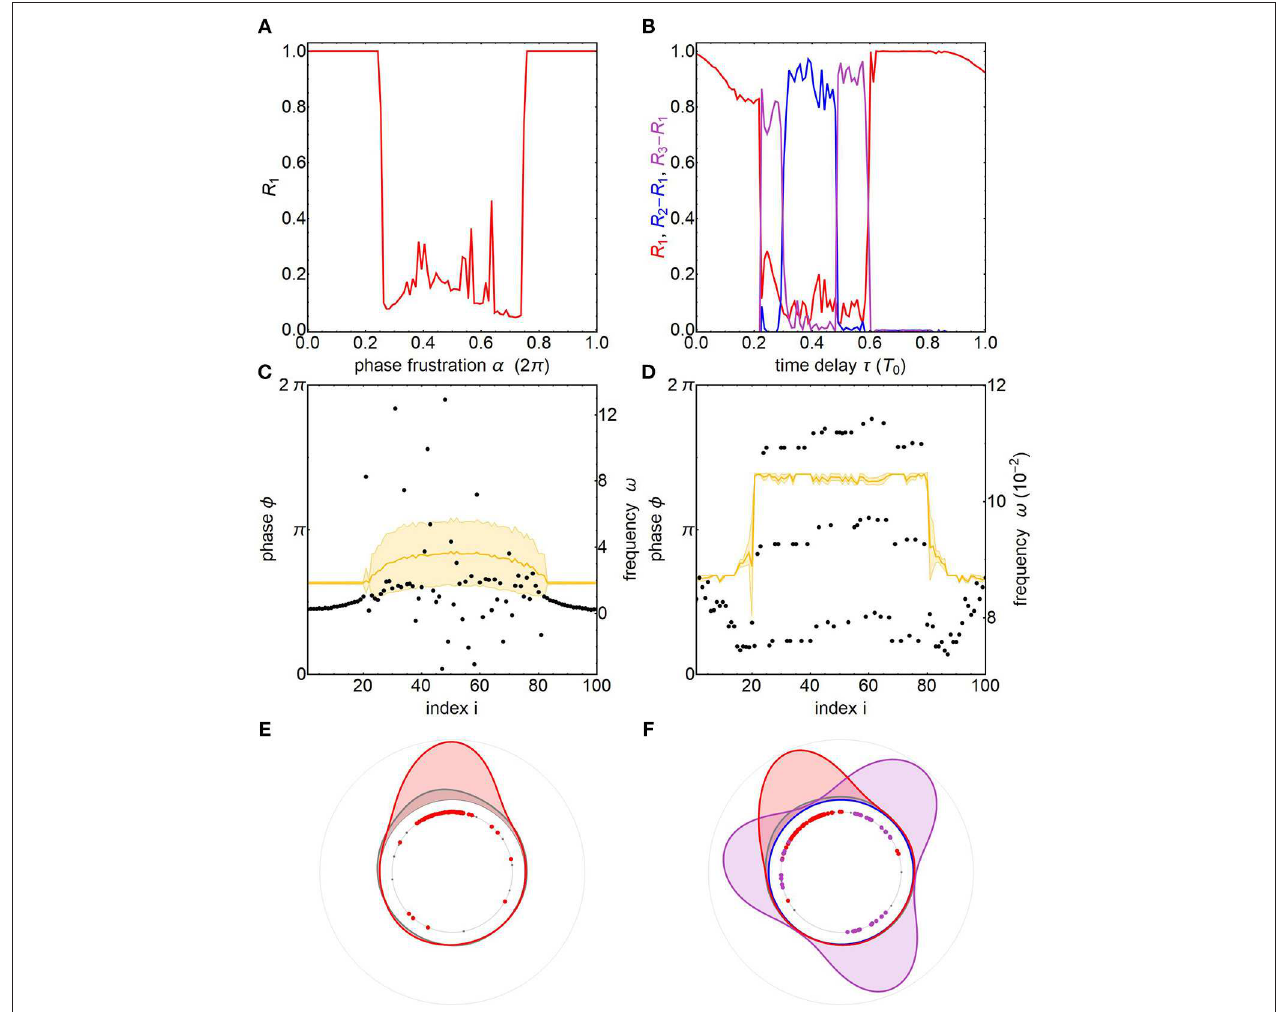
FIGURE 2 | Comparison of chimera states in weakly and strongly coupled oscillators on a ring. Left column: Kuramoto phase oscillators (Equation 1), Right column: ZBKE relaxation oscillators (Equation 2). (A,B) Collective dynamics in a globally coupled network quantified by Kuramoto order parameters as a function of synchronization frustration ( α , τ ) exhibiting in-phase synchronization, incoherence and d -clusters with d ∈ { 2,3 } . Parameters for phase (ZBKE) oscillators: K = 50, 1 t = 5 × 10 − 3 ( K = 4 × 10 − 5 , 1 t = 2 × 10 − 4 ). (C,D) Collective dynamics on a nonlocally coupled ring network consisting of dynamic modes found in a globally coupled network. Snapshots show phases (black) and frequencies (yellow). Parameters for phase (ZBKE) oscillators: K = 0.1, κ = 35, α = 1.457 ( K = 7.93 × 10 − 4 , κ = 2, τ = 8.67, q ∈ [0.69,0.71]). (E,F) Smoothed distributions of in-phase (red), 3-cluster (purple) and incoherent (gray) oscillator populations on the phase circle. Parameters: N = 100. Others as in Figure 1